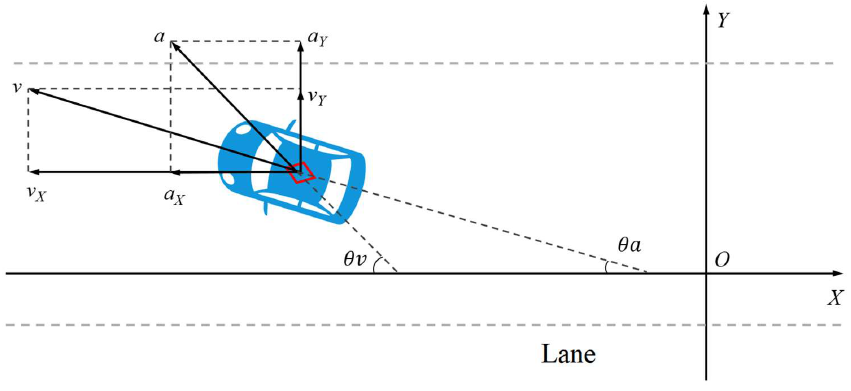
Figure 3. Vehicle track